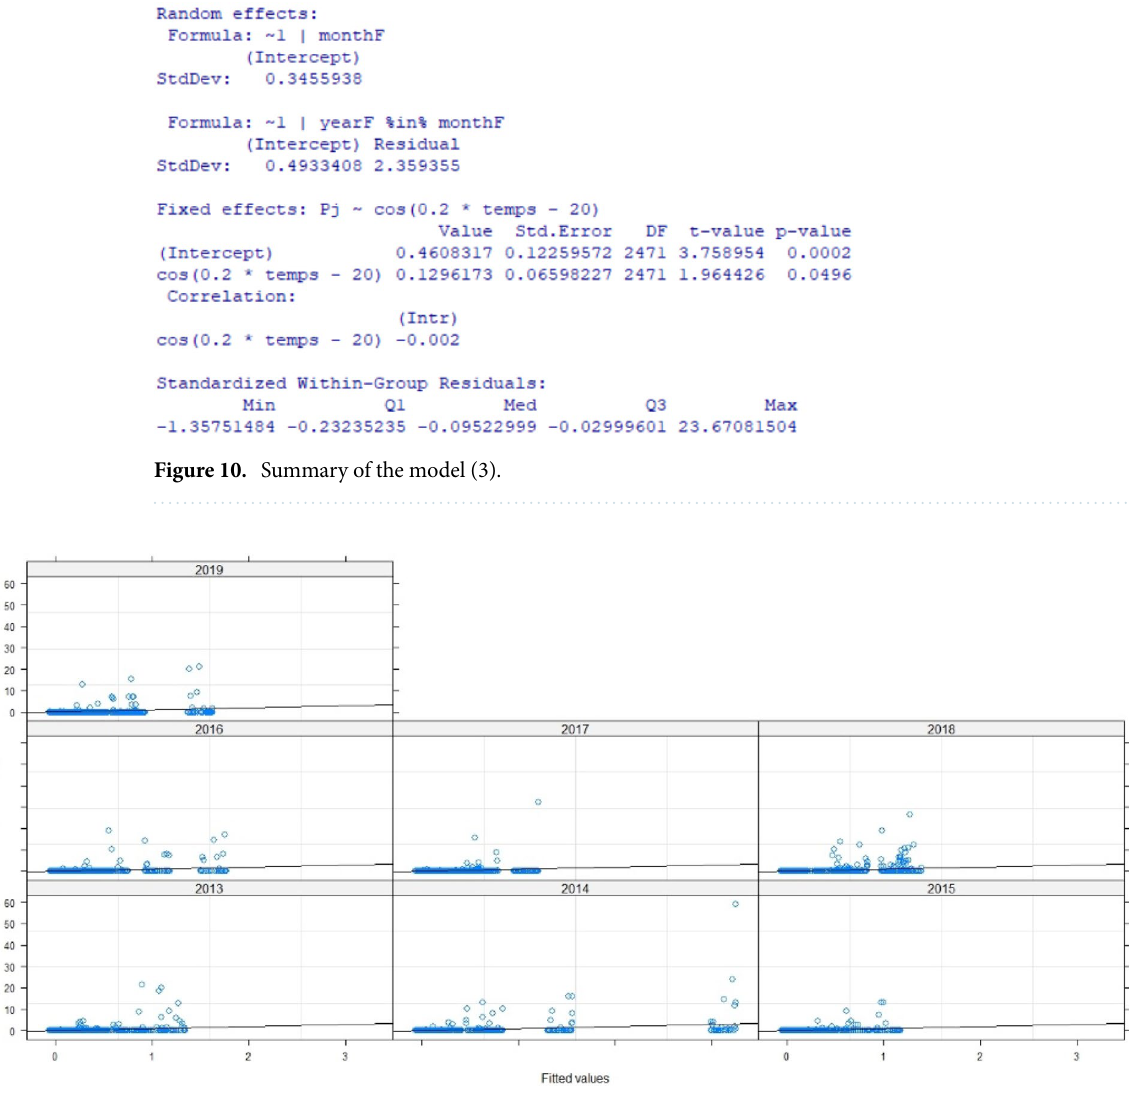
Figure 11. Precipitation in terms of the adjusted